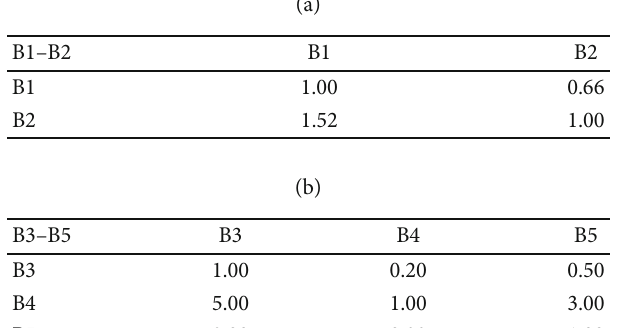
Table 7: Second layer attribute judgment matrices.